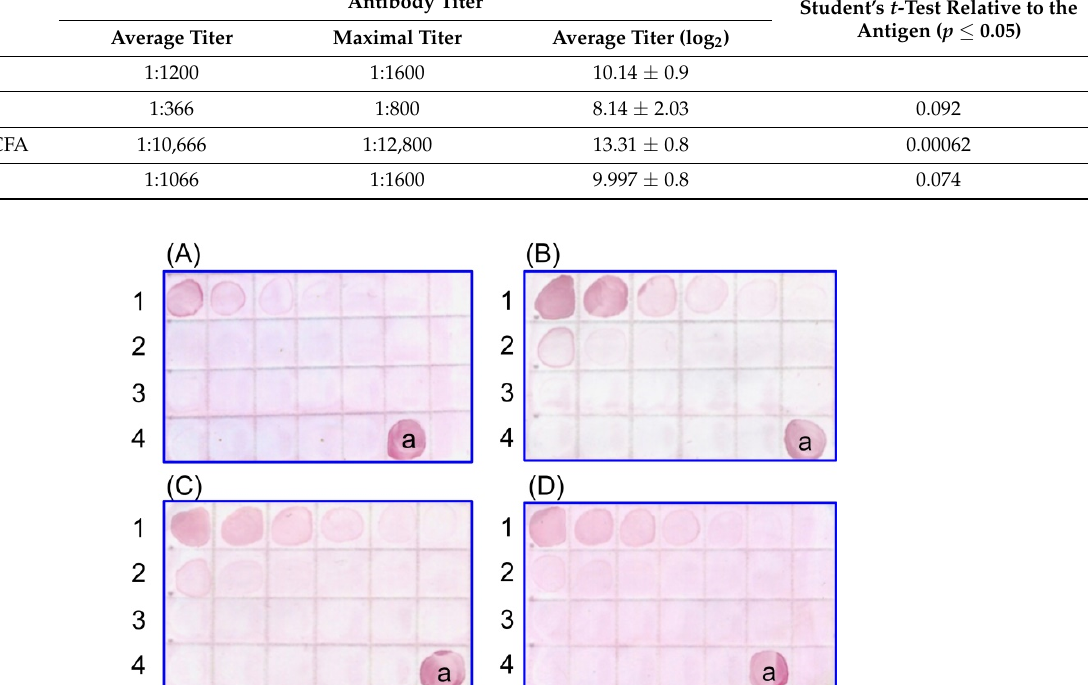
Figure 3. Dot immunoassay of antigens with antisera from mice immunized with antigen ( A ), GNPs + antigen ( B ), GNPs + antigen + CFA ( C ), and GNPs ( D ). 1, MN22a. 2, HeLa. 3, SPEV-2. 4a, serum (positive control).